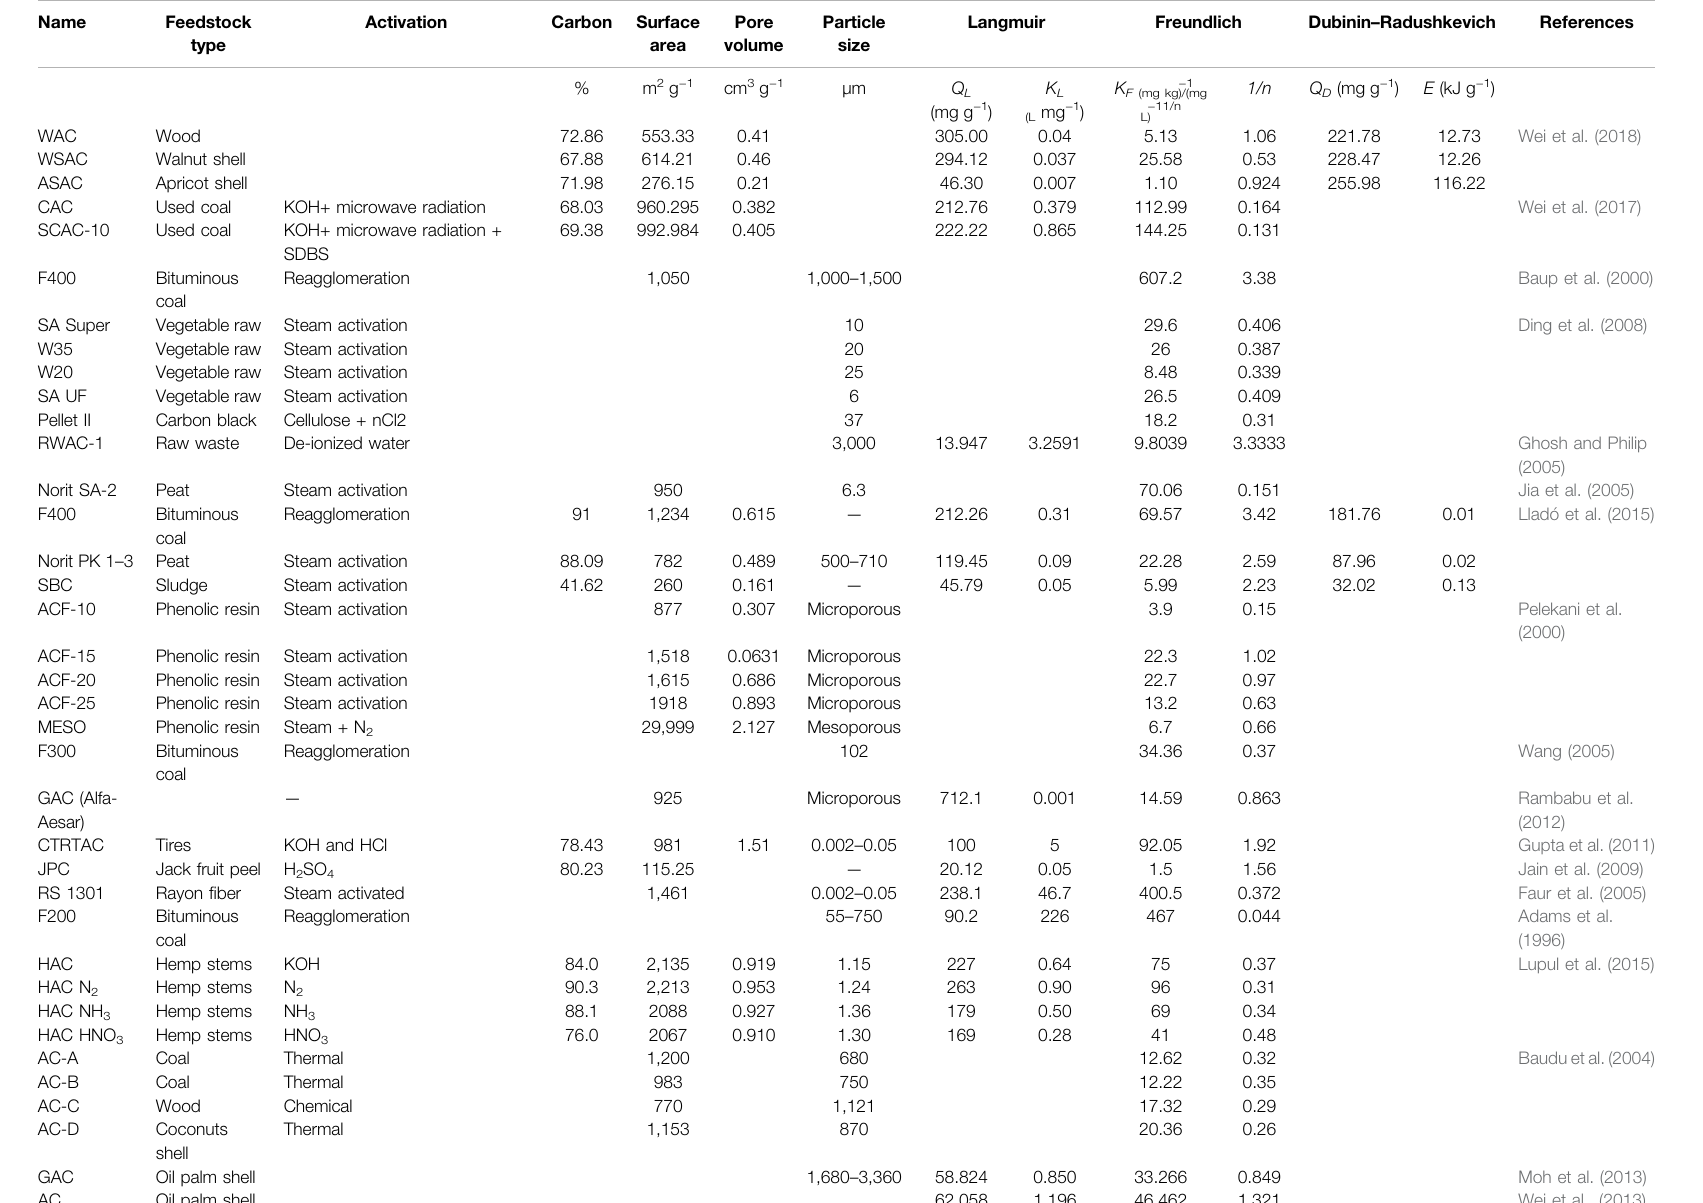
TABLE 1 | Ef fi ciency of various activated carbons for the removal of atrazine from aqueous media as predicted by Langmuir, Freundlich, and Dubinin – Radushkevich isotherms.